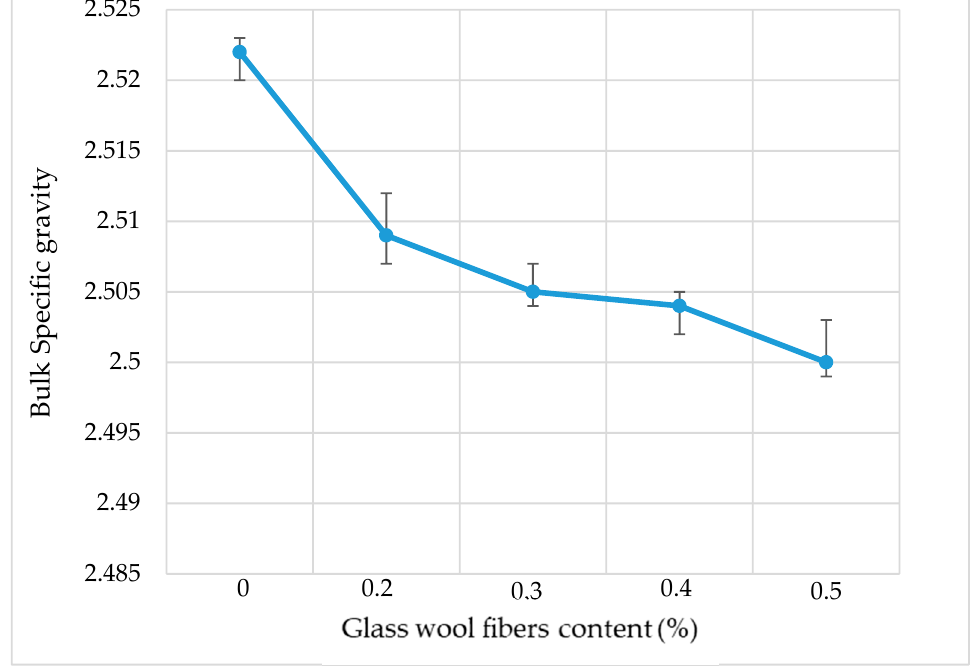
Figure 7. Marshall stability . Glass wool fibers content (%)